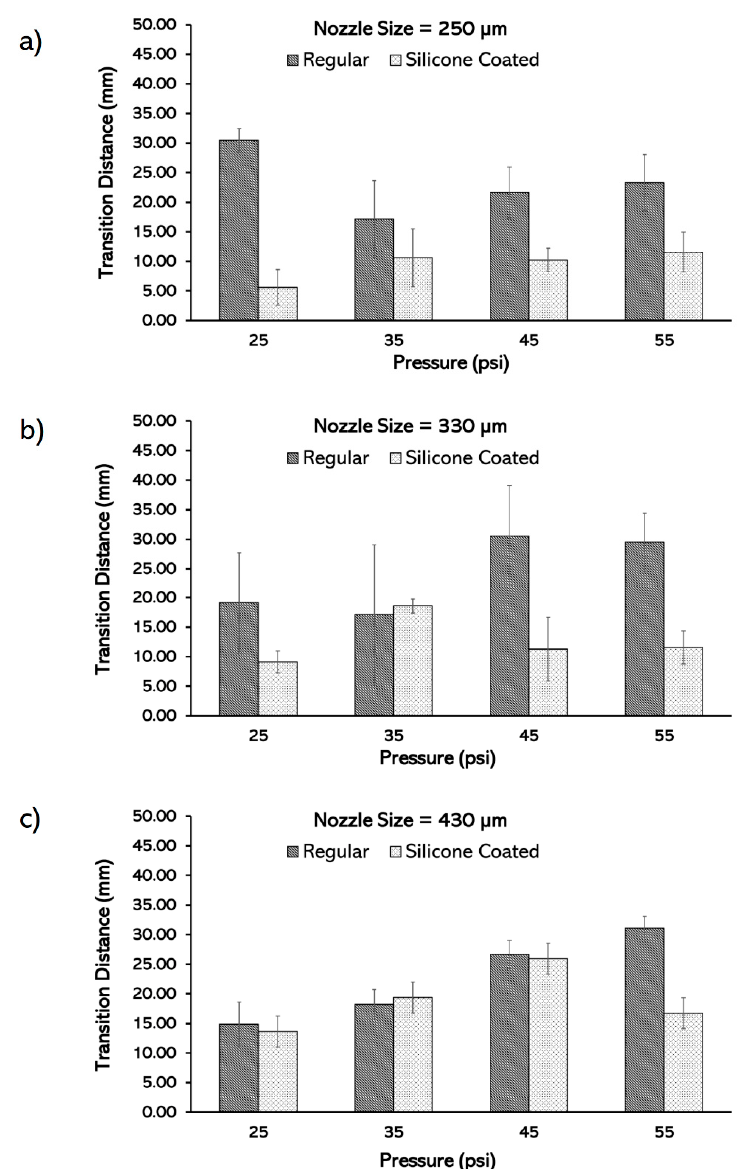
Figure 5. Characterization of the transition distance based on pressure in regular and silicone-coated printheads in different nozzle sizes: ( a ) 250 μ m, ( b ) 330 μ m, and ( c ) 430 μ m.